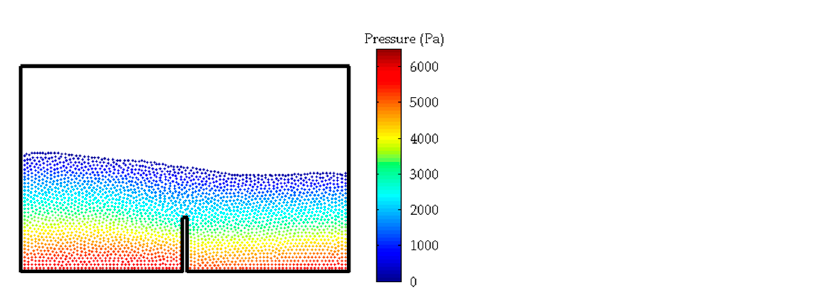
Figure 33. Flow pattern in the STAR-CCM+ simulation with the baffle.